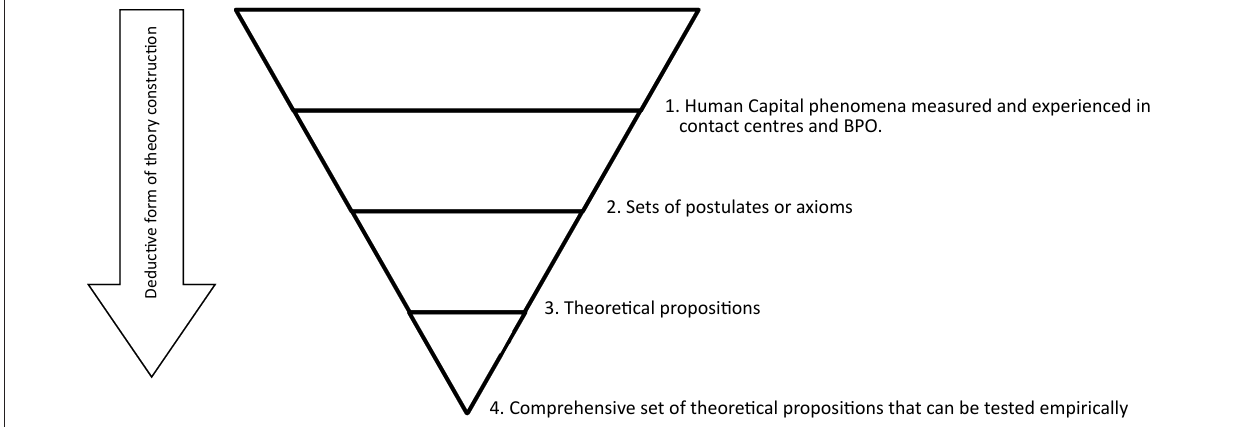
FIGURE 1 : The model building research